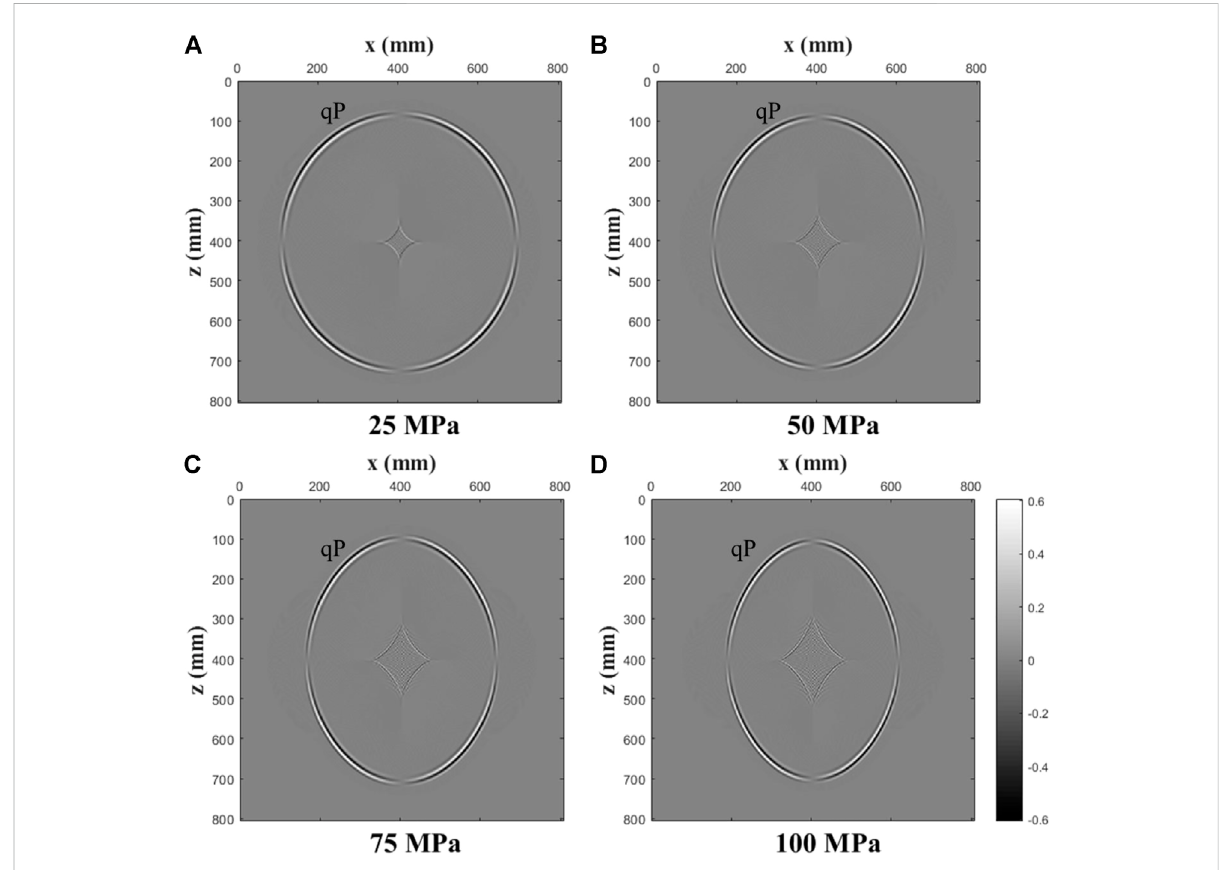
FIGURE 8 Decoupled P-wave fi eld snapshots of the x-component of the particle velocity at t = 0.1 ms for various uniaxial stresses ( (A) : 25 MPa; (B) : 50 MPa; (C) : 75 MPa; (D) : 100 MPa).